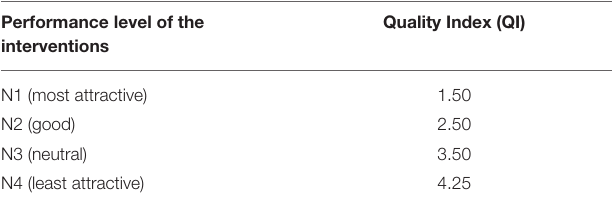
TABLE 4 | Performance scale of the interventions relative to pavement condition. Performance level of the interventions